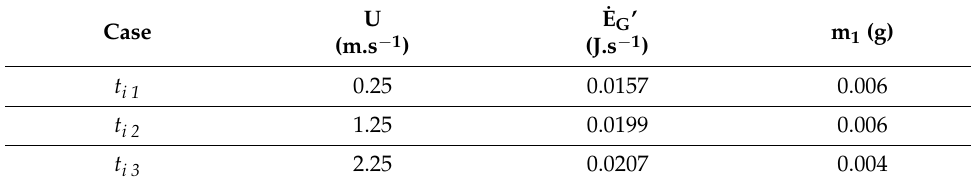
Figure 13. Average values of time delay to ignition t i as a function of fuel bed moisture content x for tests with constant values of wind velocity. The curves correspond to model predictions of t i (Equation (39)), for the parameters given Table 7. Table 7. Model parameters used in the cases illustrated in Figure